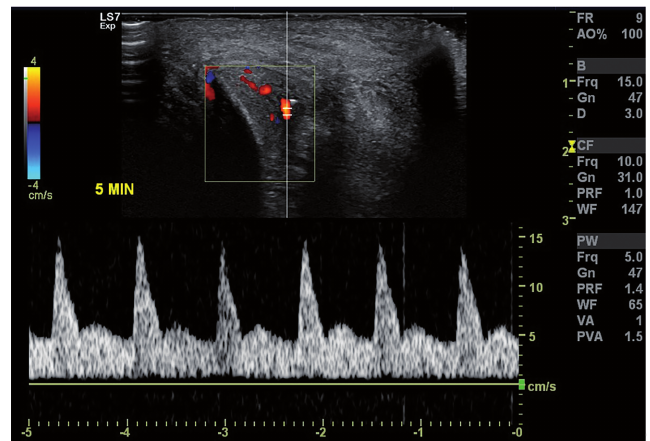
Figure 2 - Penile color duplex Doppler ultrasound after pharmacological induced erection test through Alprostadil intracavernous injection excluding vascular disease in a patient with erectile dysfunction after a penile fracture.